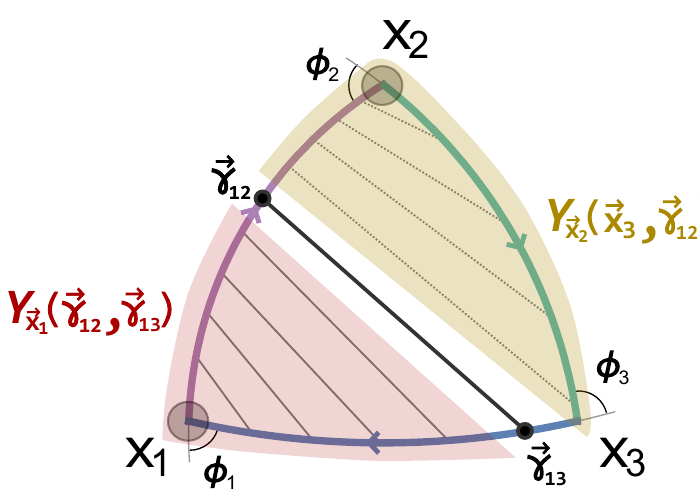
Figure 10 . We split the propagators into two groups by explicitly writing the last propagator between ~(cid:13) 12 and ~(cid:13) 13 . Then we re-sum the propagators surrounding cusp x 2 into Y ~x those around x 1 into Y ~x ( ~(cid:13) 12 ;~(cid:13) 13 1